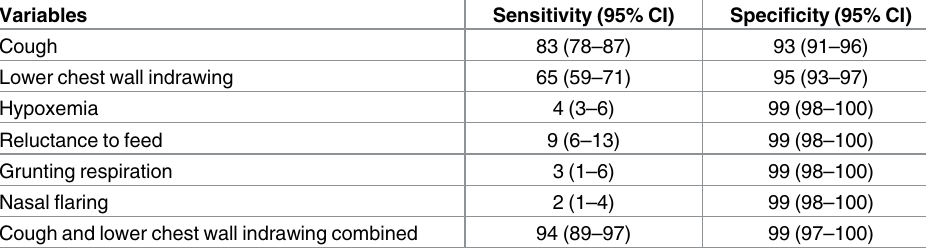
Table 3. Sensitivity and specificity of the clinical predictors of pneumonia in diarrheal children having age specific fast